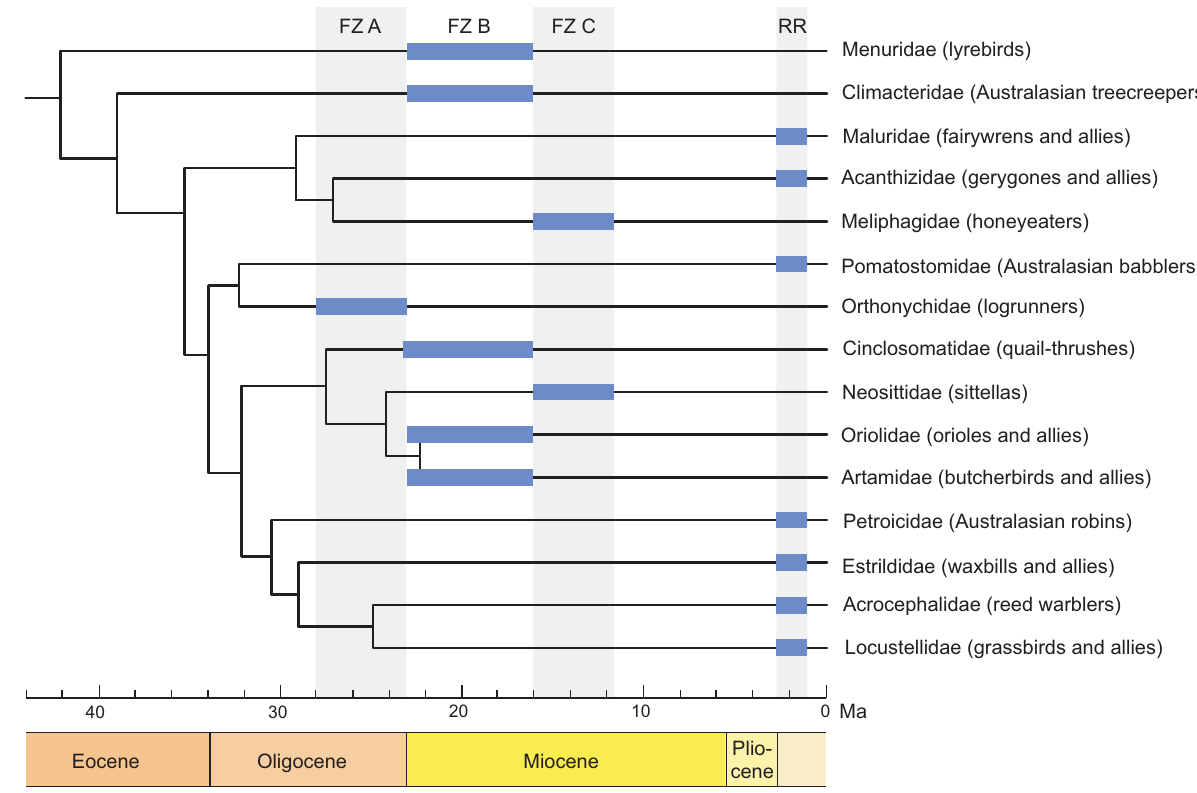
Fig. 3. Passerine groups known from Riversleigh’s Cenozoic assemblages and their interrelationships, based on the time-calibrated phylogeny of Selvatti et al. (2015). Thick horizontal bars indicate the earliest temporal occurrences of passerine groups in the Riversleigh faunal assemblages, based on Boles (1999, 2005), Nguyen et al. (2013, 2014, 2016), and Nguyen (2016). The estimated age ranges of the Riversleigh Faunal Zones and the Rackham’s Roost Local Fauna are from Archer et al. (1989), Creaser (1997), Travouillon et al. (2006), Arena et al. (2015), and Woodhead et al. (2016). Abbreviations: FZ A, Faunal Zone A (late Oligocene, 28.0–23.03 Ma); FZ B, Faunal Zone B (early Miocene, 23.0–16.0 Ma); FZ C, Faunal Zone C (middle Miocene, 16.0–11.6 Ma); RR, Rackham’s Roost Local Fauna, Rackham’s Roost Site, Riversleigh (early Pleistocene, 2.7–1.1